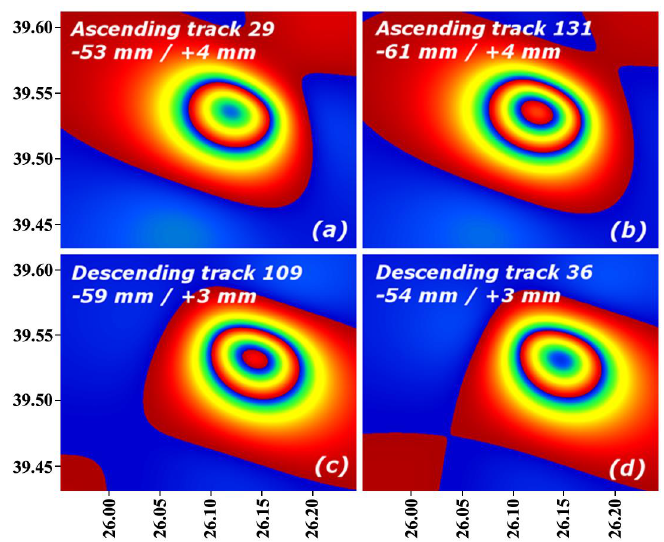
Figure 10. Synthetic interferograms based on the Gulpinar fault model (each per S1 track): ( a ) Ascending track 29, ( b ) ascending track 131, ( c ) descending track 109, ( d ) descending track 36 (overlay to DEM in Figure 9; tracks are shown in Figure 1). The amount of LOS motion is provided as a negative number for motion away from the sensor or “ subsidence ” and positive for “ uplift ” (for example for descending track 36, the “ subsidence ” vs. “ uplift ” is 54 mm vs. 3 mm, respectively).